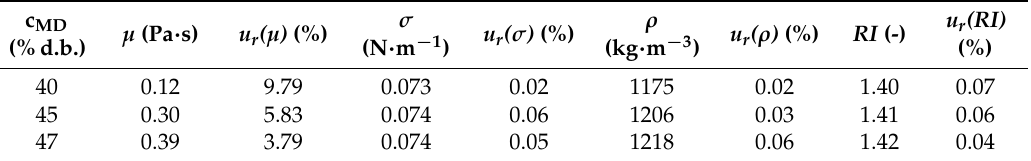
Table 1. Physical properties viscosity ( µ ), surface tension ( σ ), density ( ρ ) and refractive index ( RI ), as well as corresponding uncertainty values u r ( γ ) of the model solutions at 25 °C. Dry matter contents c MD are given as dry base values (d.b.).